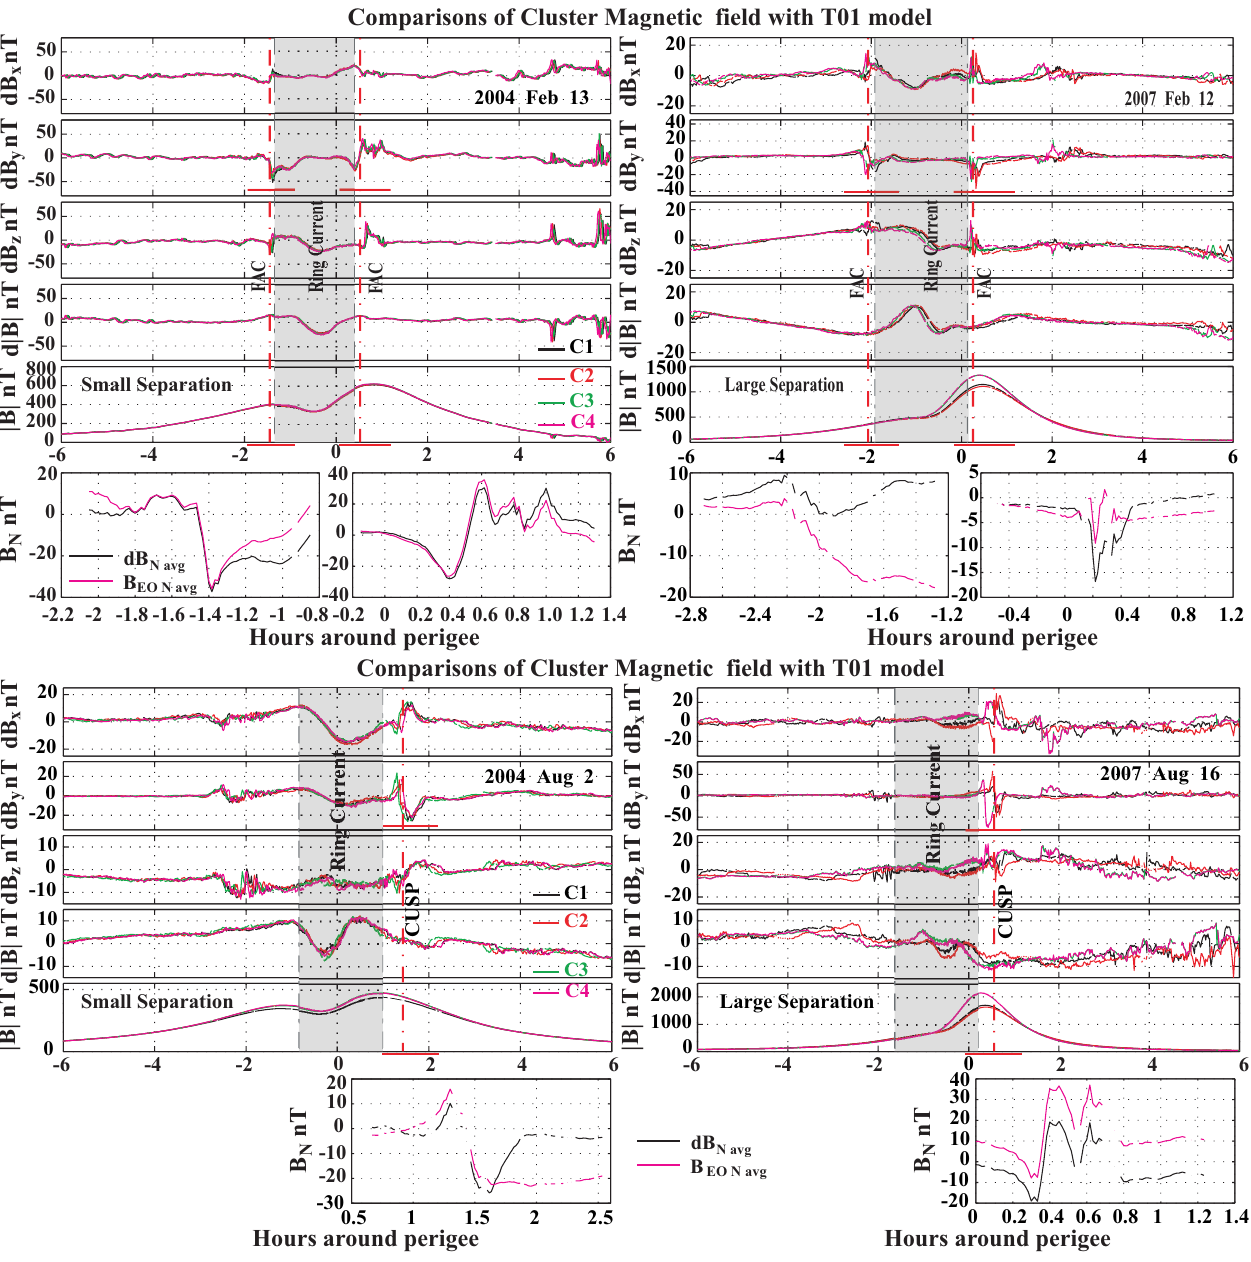
Fig. 7. Results from six orbits with different separations and different orientations of Cluster 4-spacecraft on 13 February 2004 and 12 February 2007 ( a , in small and large separation, nightside pass), on 2 August 2004 and 16 August 2007 ( b , in middle and large separation, dayside pass), and on 8 May 2004 and 4 December 2003 ( c , in small separation, both flanks pass), together with the average residual normal component of d B avg (black trace) and B EO − avg (magenta trace) for each FAC. The x-axis is time relative to the perigee for each orbit. Top four panels are residuals (data-model) of magnetic field in GSM coordinates. Fifth panel shows the magnetic field magnitude from the 4 Cluster spacecraft for the two